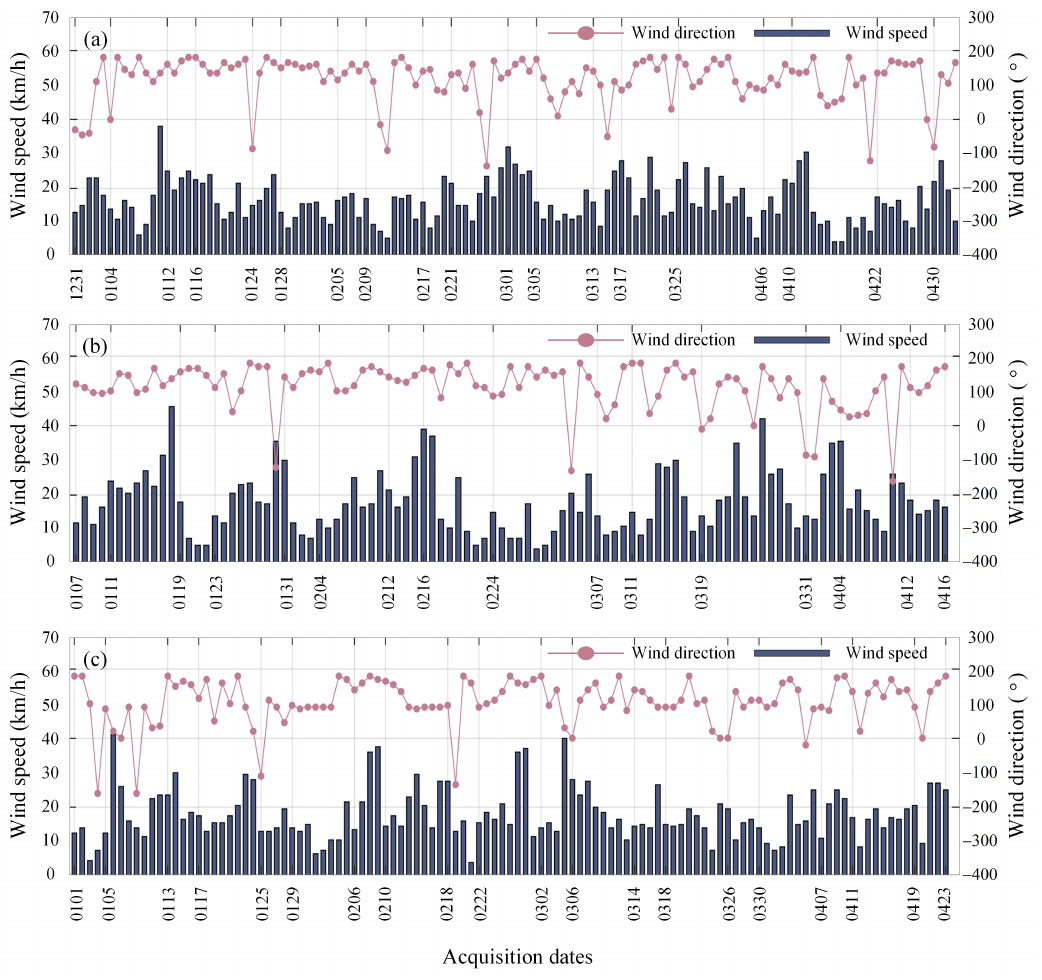
Figure 12. Collected wind data, including direction and speed, in ( a ) 2019, ( b ) 2020, and ( c ) 2021.